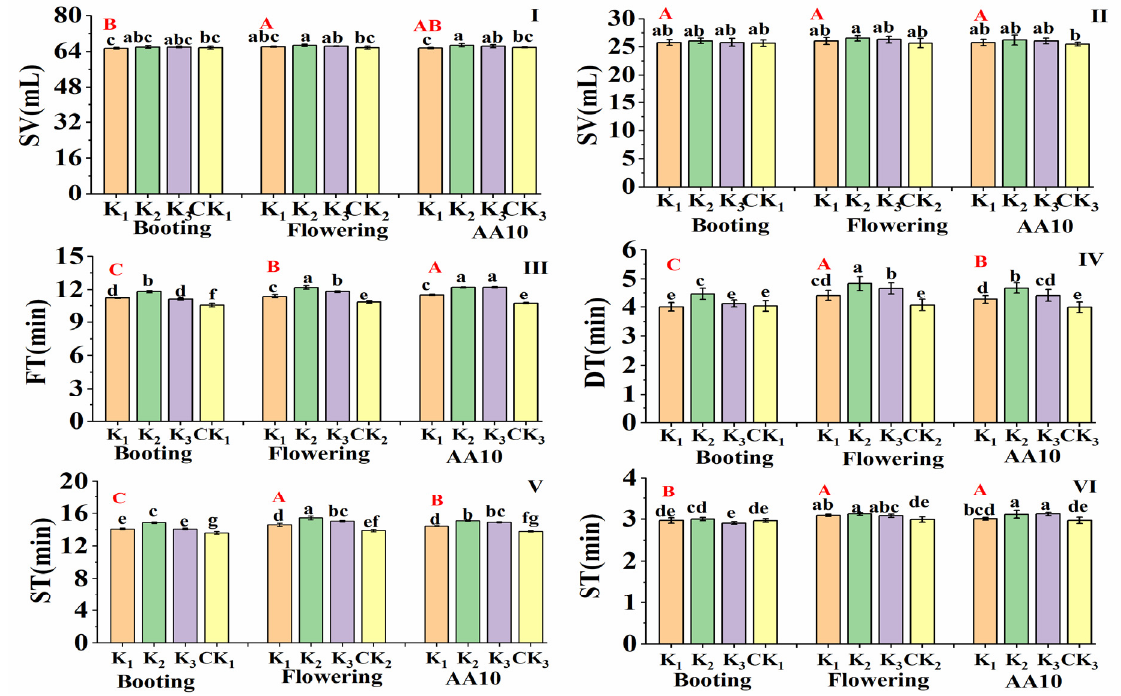
Figure 4. Effects of potassium foliar application on the rheological properties of wheat with Xinong 20 and Xiaoyan 22. I, III, and V represented Xinong 20, and II, IV, and VI represented Xiaoyan 22. Booting Booting (BBCH 48), Anthesis (BBCH 65), and AA10 (BBCH 71): Potassium fertilizer foliar sprayed at booting stage, anthesis stages, and 10 days post anthesis, respectively. K 1 , K 2 , and K 3 represented the application concentration of potassium 30, 60, and 90 mmol L − 1 , respectively. CK: Same amount of deionized water was sprayed on the leaves. Vertical bars represent the mean values ± standard deviation (n = 3). Different lower-case letters indicate a significant difference ( p < 0.05). Different capital letters indicate a significant difference ( p < 0.05) among different spraying stages.